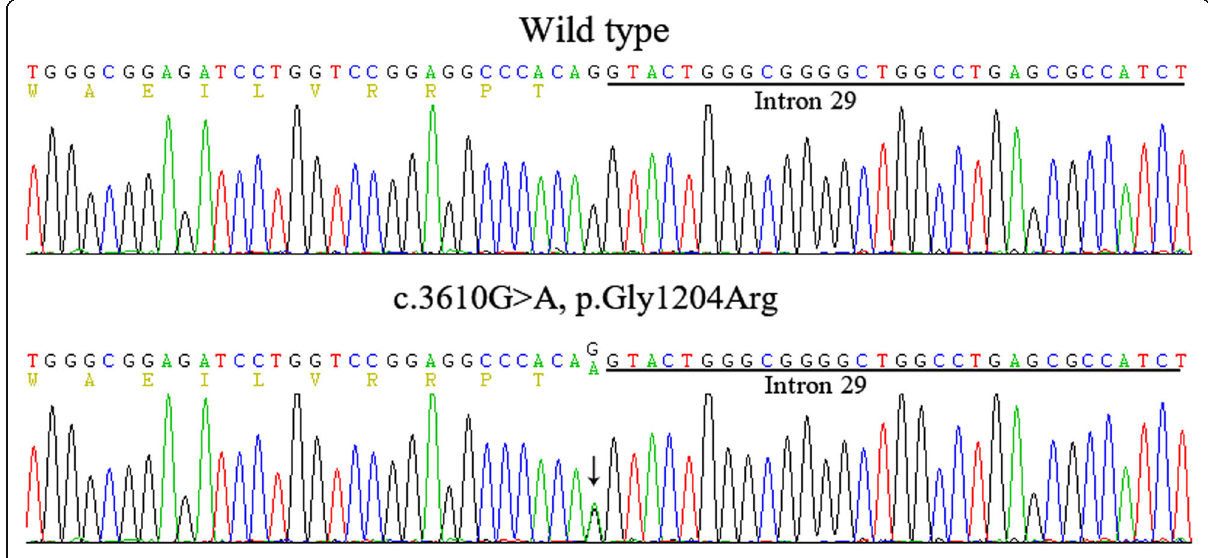
Fig. 6 TSC2 mutations identified in the proband Ib with